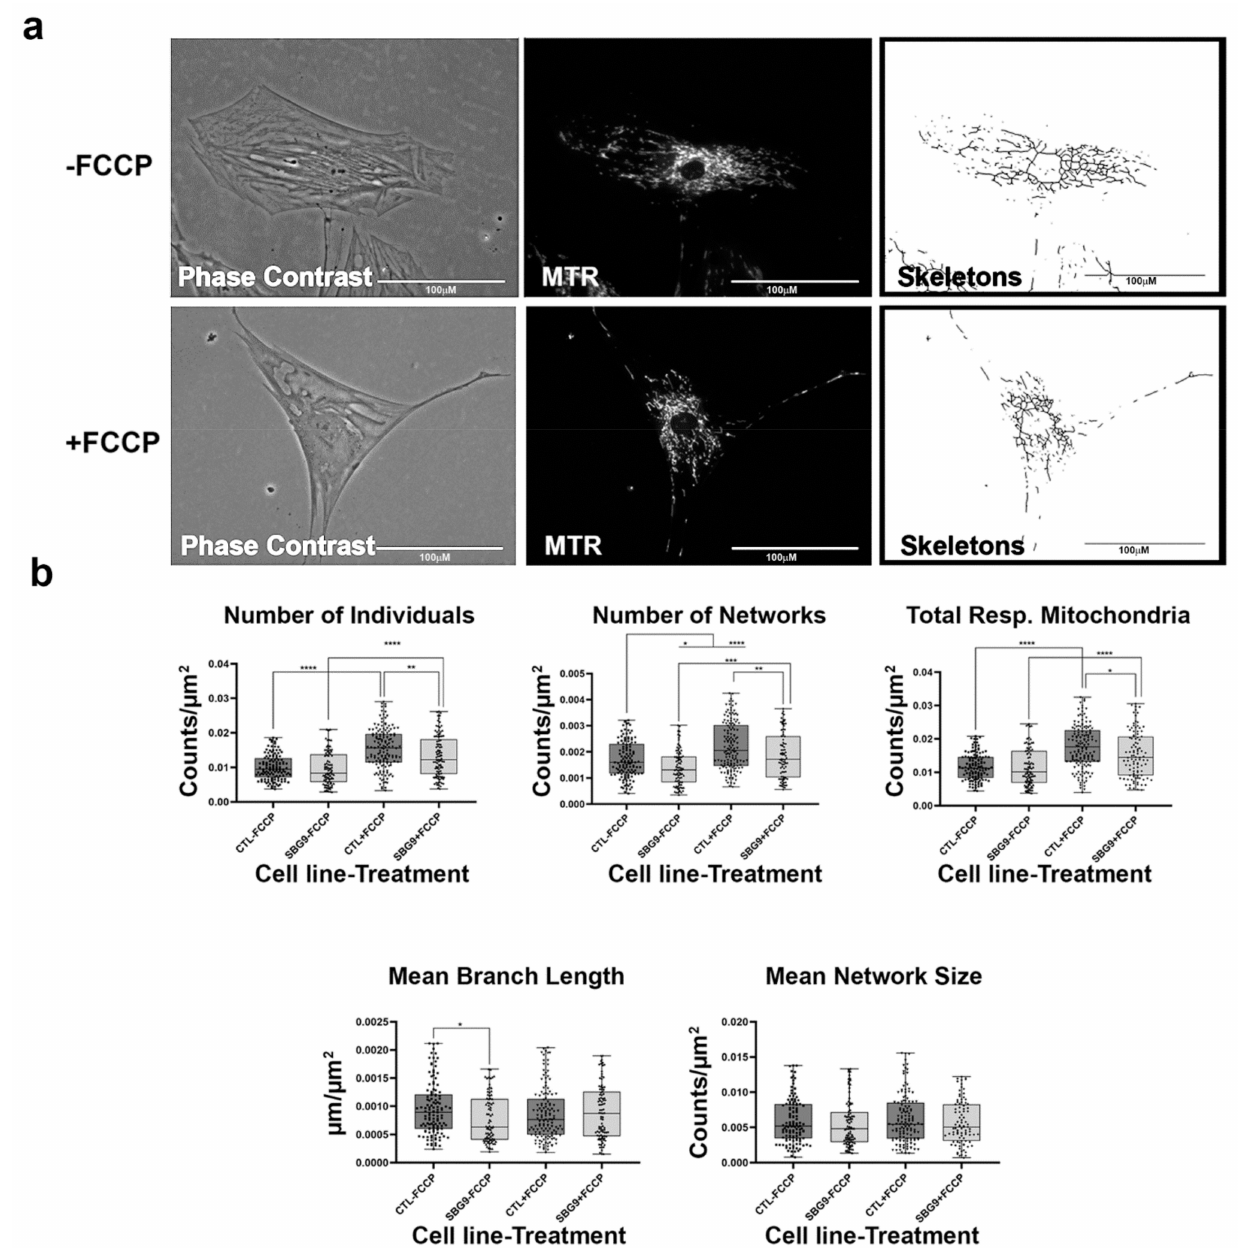
Figure 11. Mitochondrial morphology of SBG9 fibroblast in the absence and presence of FCCP. ( a ) Representative images of SBG9 fibroblast cell lines stained with MTR. The top images are phase contrast, RFP, and skeletonized images of SBG9 fibroblast cell lines without FCCP treatment. The bottom images are phase contrast, RFP, and skeletonized images of SBG9 fibroblasts with FCCP treatment. ( b ) The mean branch length is significantly lower in SBG9 fibroblast cell lines relative to the healthy BJ control fibroblasts. All data are representative of 10–14 images taken from three independent dishes per treatment group. The bars represent minimum and maximal values, and each black dot represents different data